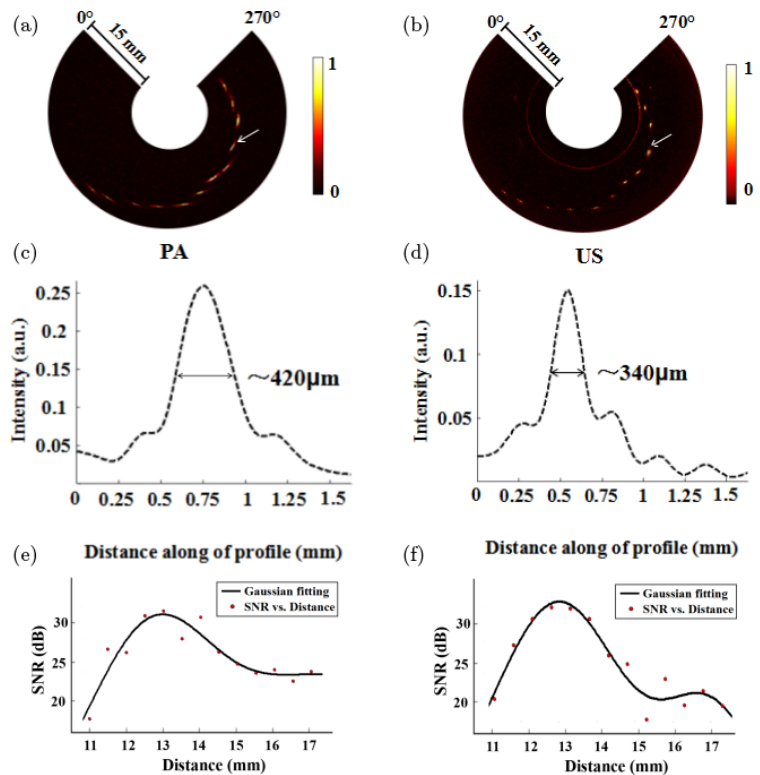
Fig. 2. Evaluation of the system resolutions and SNRs. (a) and (b) Representative PA and ultrasonic B-scan images (Hilbert transformed) acquired from the hair phantom. (c) and (d) FWHM of the pro¯les for the selected targets located at the acoustic focus indicated by white arrows in (a) and (b). (e) and (f) Calculated SNRs of the hair with the increase of the depth.